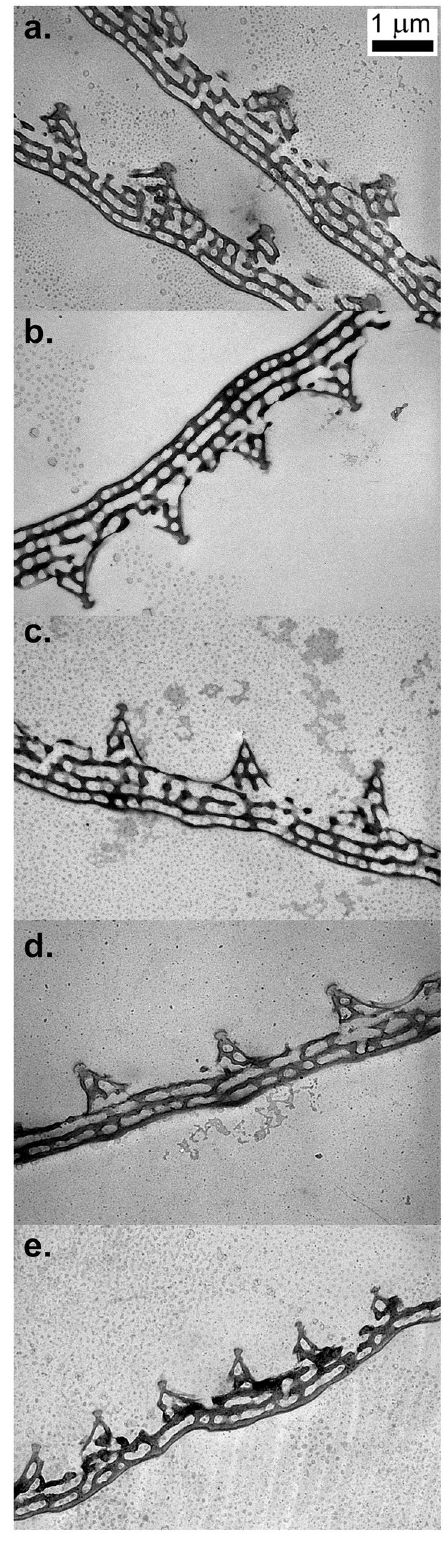
Figure 8. TEM images of cross sections through the blue coloured scales of males and females. ( a ) Wild male, ( b ) male emerged from a pupa cooled for 22 days, ( c ) male emerged from a pupa cooled for 62 days, ( d ) female emerged from a pupa cooled for 20 days, ( e ) female emerged from a pupa cooled for 40